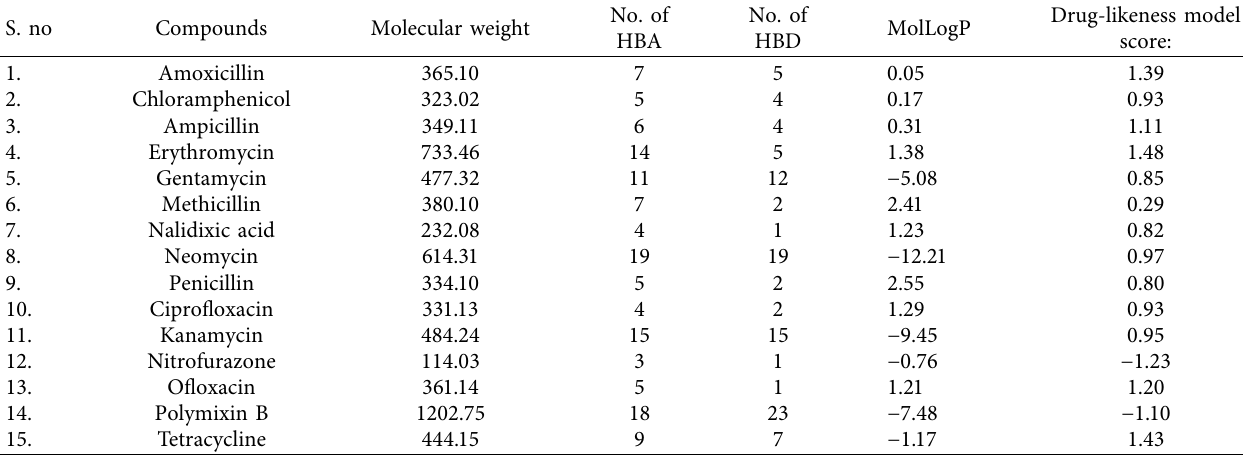
Table 10: Drug-likeness properties of the diferent drugs used in this study. S. no